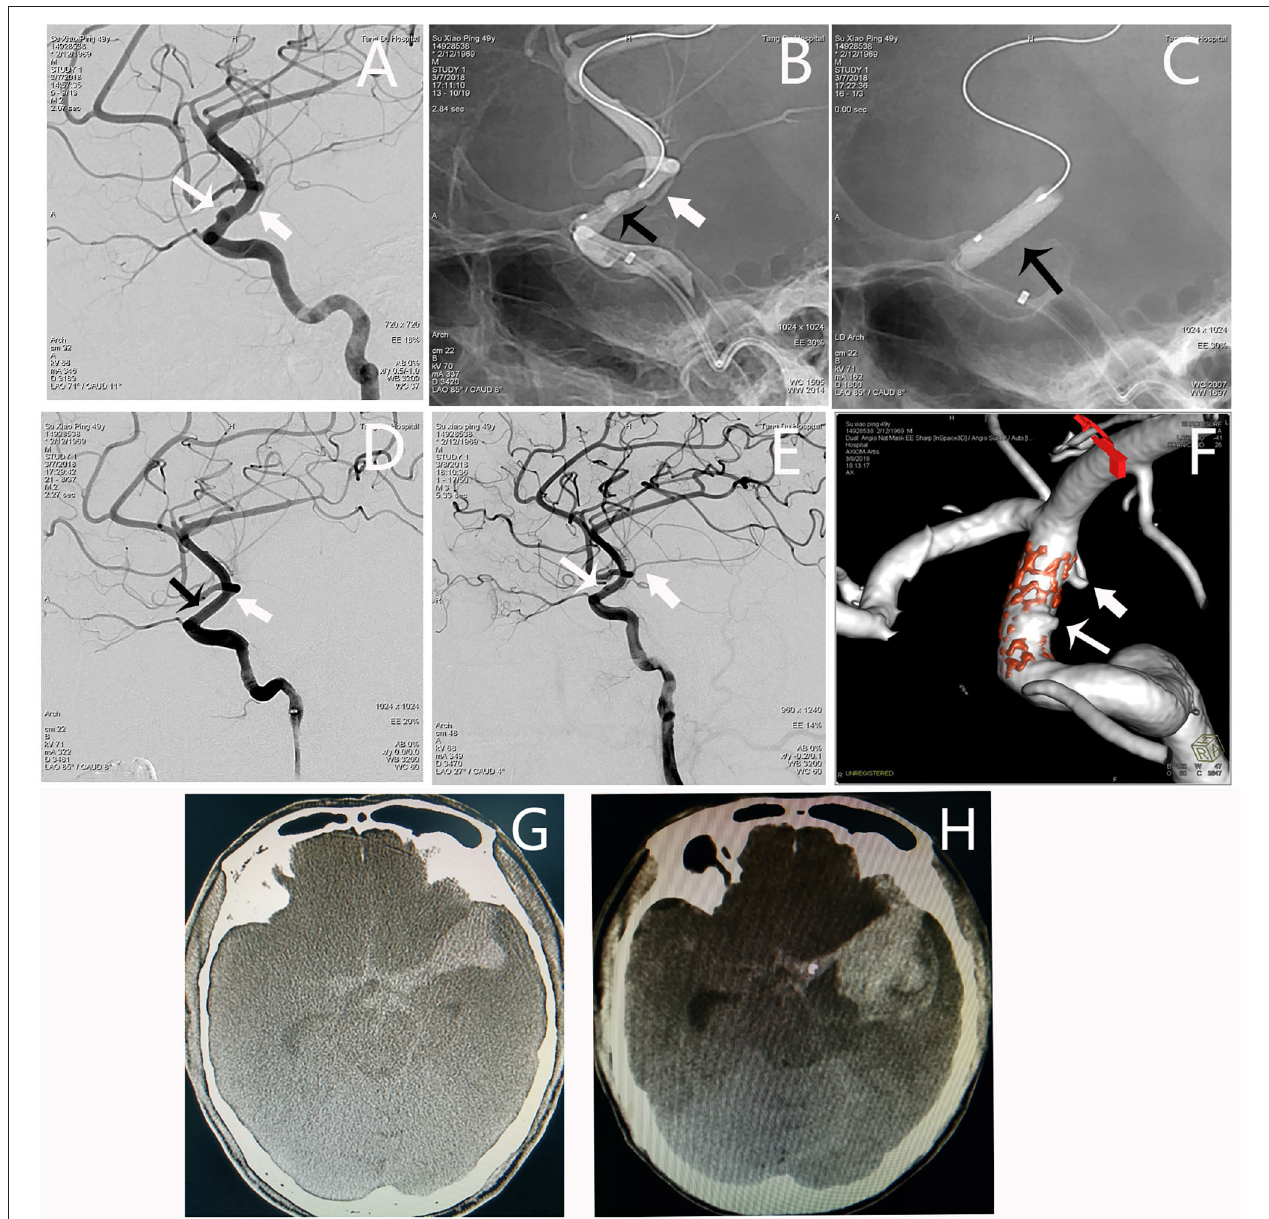
FIGURE 4 | Angiographic images of a 49-year-old man (Patient no. 13 in Table 1 ) with a L-ICA C6 BBA. (A) A BBA (1.8*5.1mm) located on the lateral wall of the C6 segment (white thin arrow); the AHCA was indicated by the white fat arrow. (B,C) A 3.5*10-mm WCS was deployed (black arrow). (D) Immediate postoperative angiography showing the aneurysm and the ACHA were both occluded. (E,F) DSA and dual volume technology showing aneurysm recurrence, and the AChA appeared again. (G) Preoperative CT scan showing subarachnoid hemorrhage. (H) The CT scan showing significantly increased hematoma as the patient fell in